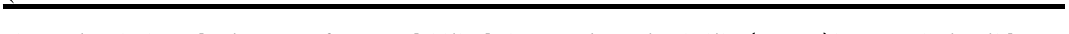
Fig. 6 –The mitotic regulated response after 3-acetylpiridine lesion. A: 5’-bromodeoxiuridine (5’-BrDu) immunostained medial cortex section of a 3AP lesioned lizard to which an injection of 5’-BrDu was delivered the day fourth after the lesion and sacrificed five days later; observe the presence of labelled nuclei both in the ependyma, in the inner plexiform layer and in the lesioned cell layer. B-C: Mitotic figures in the ependyma and radially oriented in the inner plexiform layer of 3AP lesioned lizards ten days after the lesion. D: migratory cells longitudinally arranged in the inner plexiform layer of the medial cortex of a 3AP lesioned lizard, 15 days after the lesion. E: medial cortex cell layer of a 3AP lesioned lizard, 18 days after the lesion, showing presumably just arrived fusiform nuclei. F: Semithin section of the medial cortex and its subjacent ependymary sulcus of a 3AP lesioned lizard, six months after the lesion; observe the healthy normal histological appearance. G: 5’-BrDu immunostained organotypic cultured medial cortex slice taken from a 3AP lesioned lizard to which an injection of 5’-BrDu was delivered the day fourth after the lesion, two days later the lizard was sacrificed, and the brain slice maintained for a week in culture; observe the similarities with pictureA, i.e., abundant labelled nuclei in the presumed ependymary sulcus and the radially dispersed appearance until reaching the presumed medial cortex cell layer. (Scale bar represents 50 µ m in A, 40 µ m in B, D, E and G, 30 µ m in C and 70 µ m in